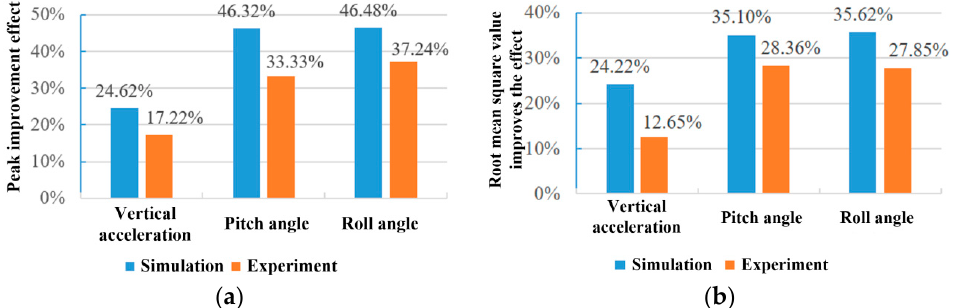
Figure 14. The comparison between simulation and experimental results under bump road disturbances: ( a ) Peak value contrast; ( b )RMS value.